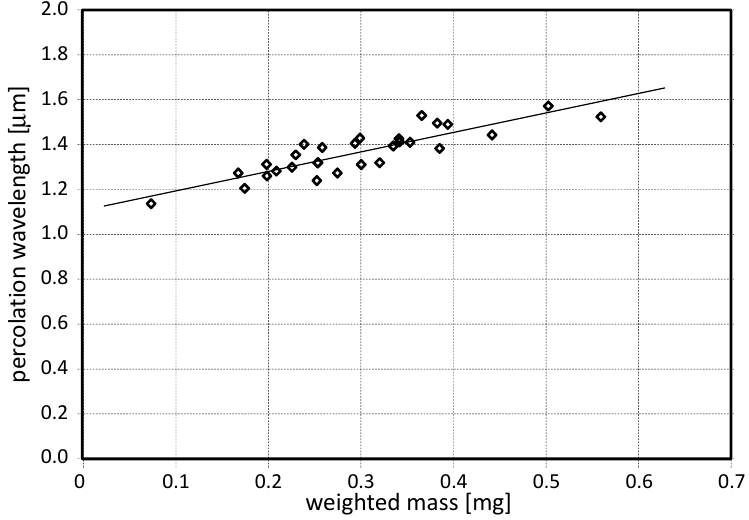
Figure 6. Percolation characteristic wavelength as a function of the weighted mass for the whole sampling campaign in the museum. The linear fit has a coefficient of determination R 2 as high as 0.80. Such a plot provides a fine calibration for retrieving the mass data from the optical ones.